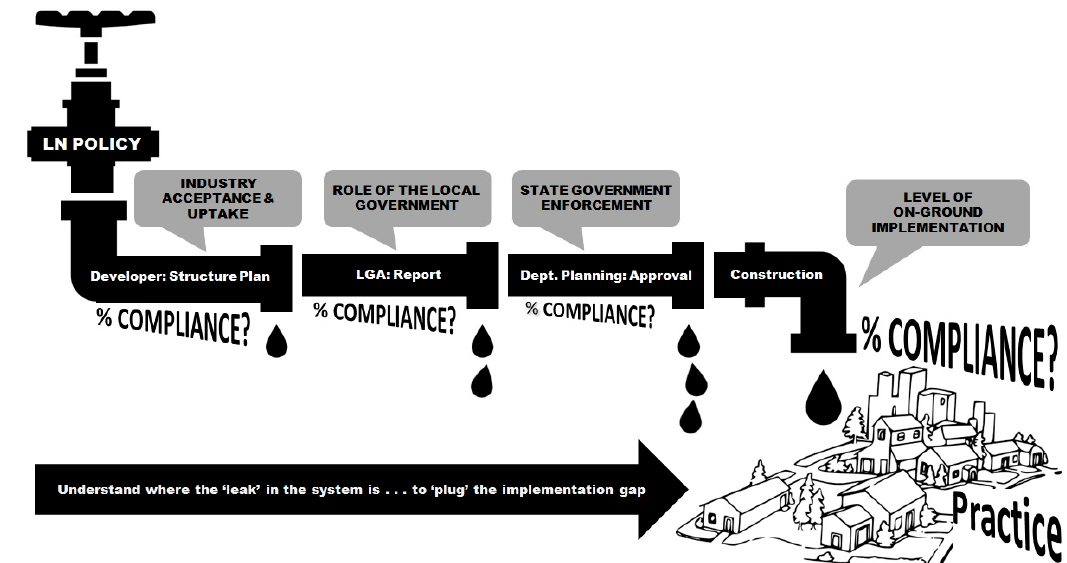
Figure 2. The ‘leaky pipe’ of the policy pipeline process for the Liveable Neighbourhoods Community Design policy in Perth, Western Australia.